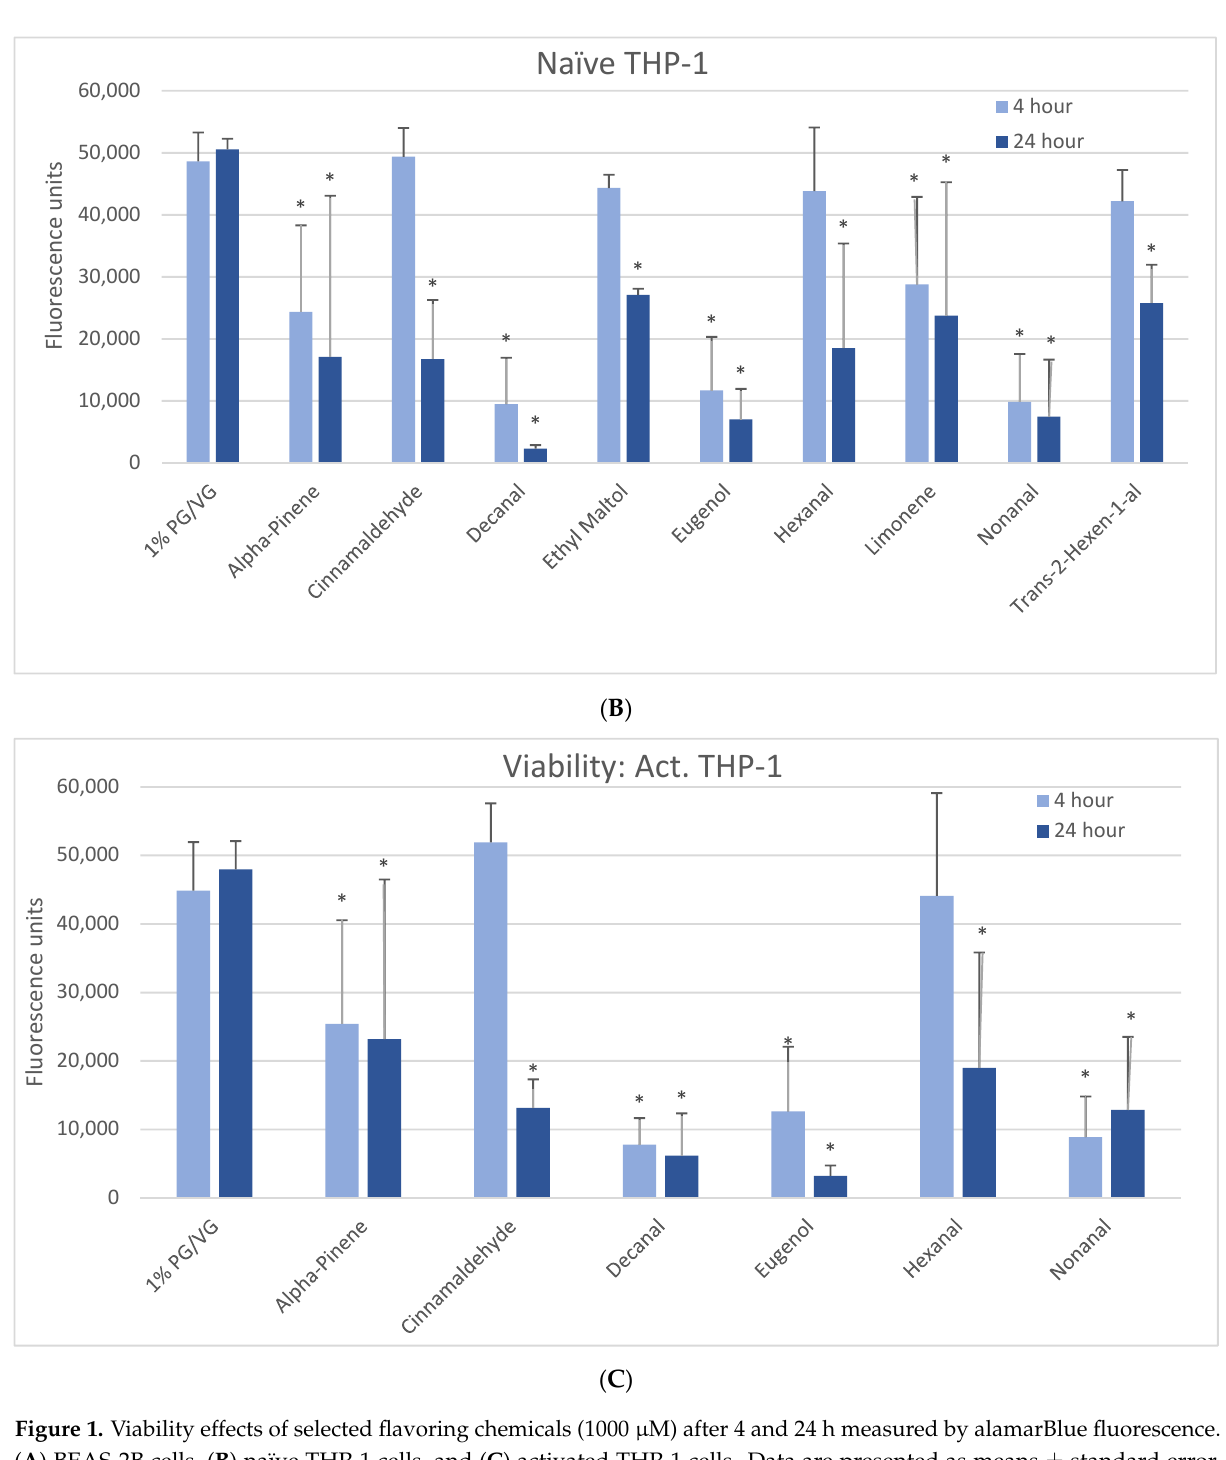
Figure 1. Viability effects of selected flavoring chemicals (1000 µ M) after 4 and 24 h measured by alamarBlue fluorescence. ( A ) BEAS-2B cells, ( B ) naïve THP-1 cells, and ( C ) activated THP-1 cells. Data are presented as means ± standard error. Significance: * p < 0.05 as compared with vehicle control (1%PG/VG).